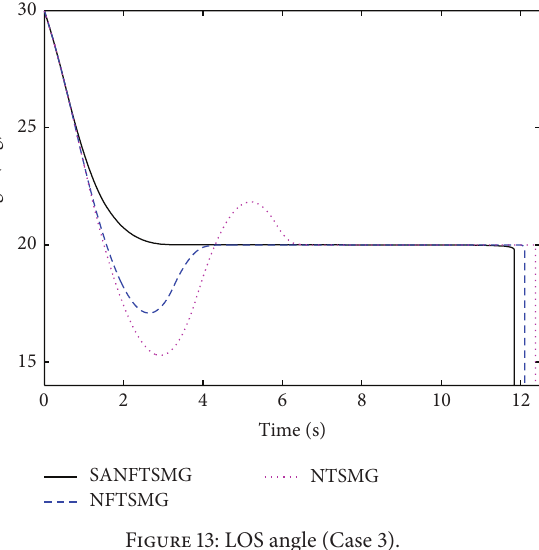
Figure 13: LOS angle (Case